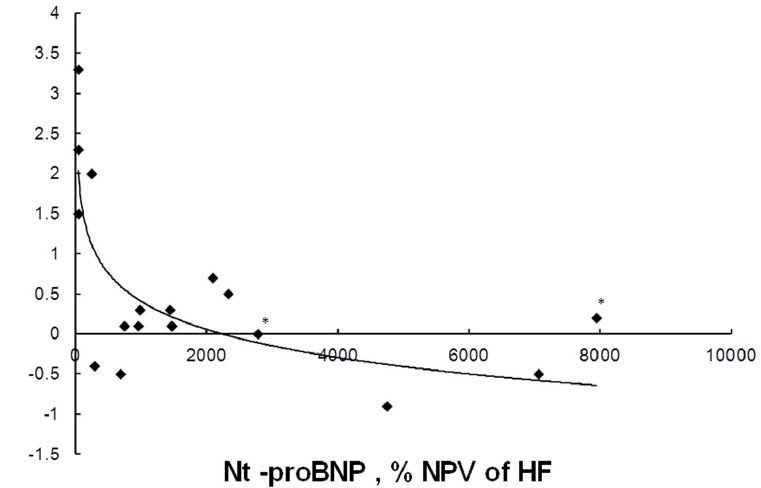
Figure 6. Difference between cardiac output measured at the end of a CPET and of a 6MWT in relation with Ntpro-BNP level in % of the highest negative predictive value for age in 18 PH patients (* indicate patients with high creatinine level).